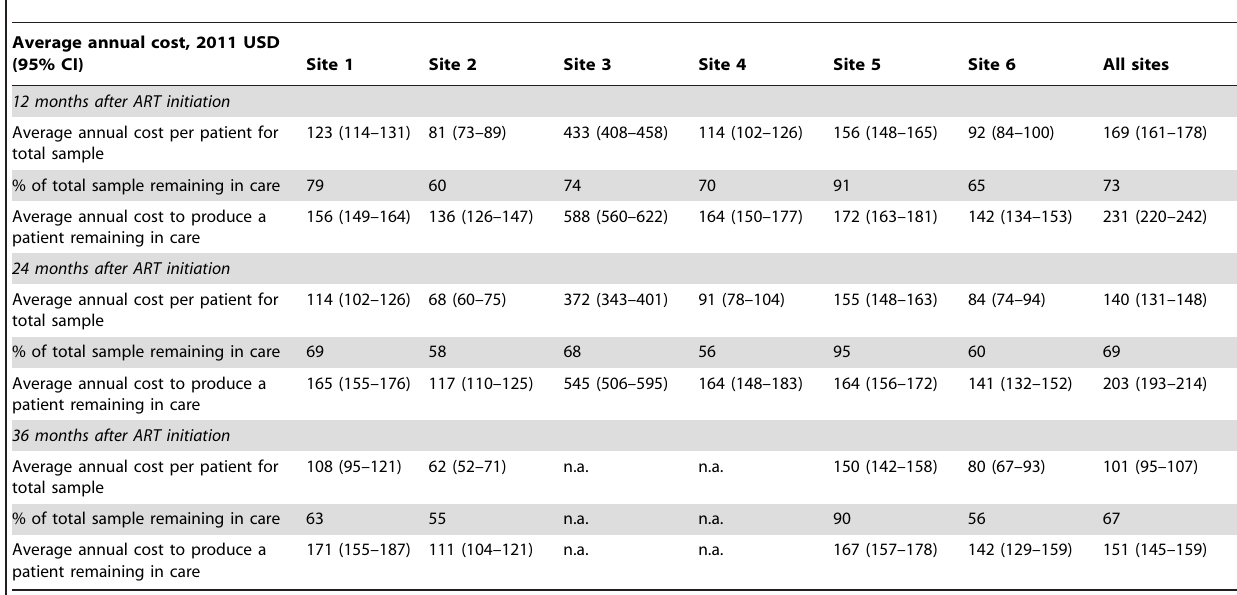
Table 6. Average annual cost to produce a patient in care at six ART treatment sites in Zambia by site and time on treatment.